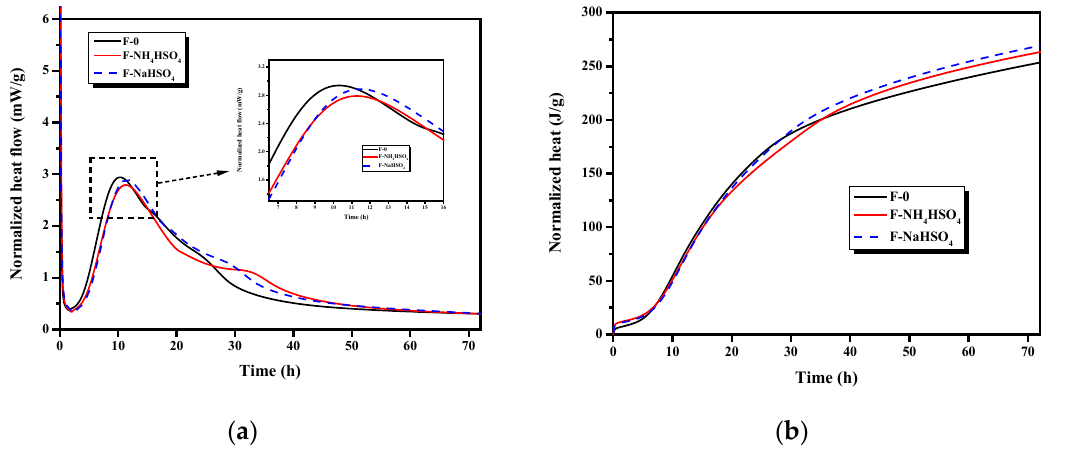
Figure 5. Effect of different sulfates on ( a ) heat flow curve and ( b ) cumulative heat release of the cement fly ash system. cement fly ash